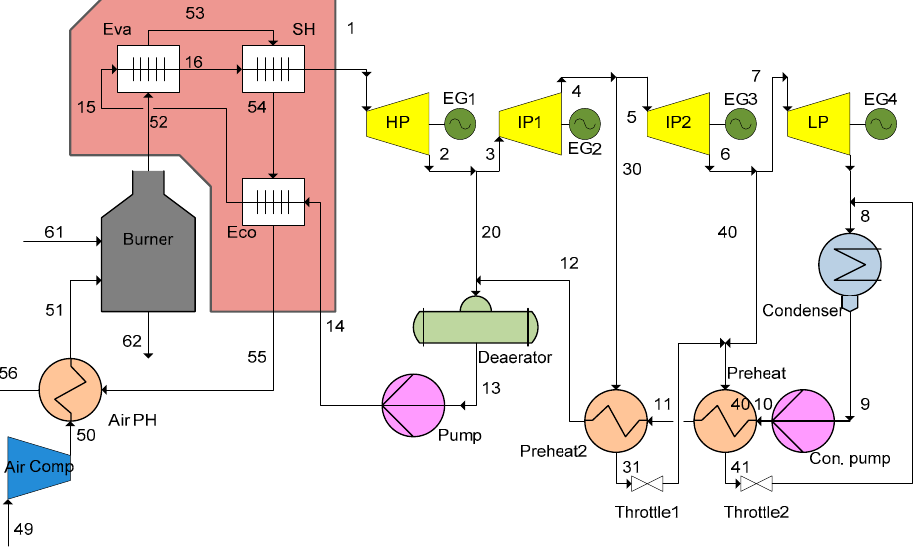
Figure 1. Kyndby original coal steam plant.